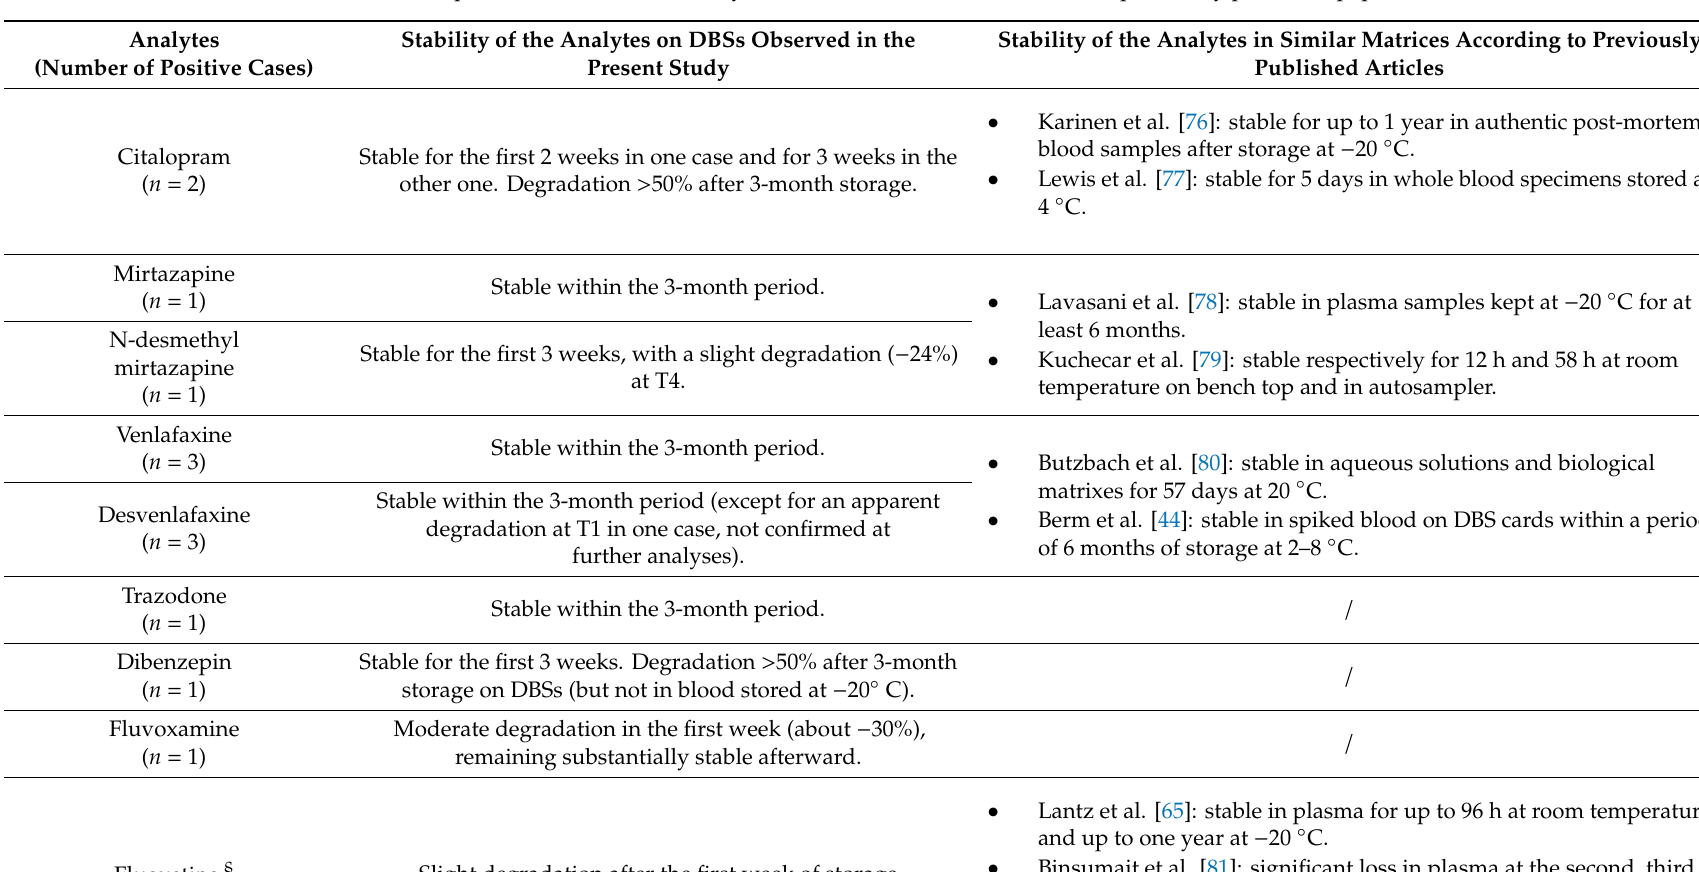
Table 5. Comparison between our stability results and those ones obtained from previously published